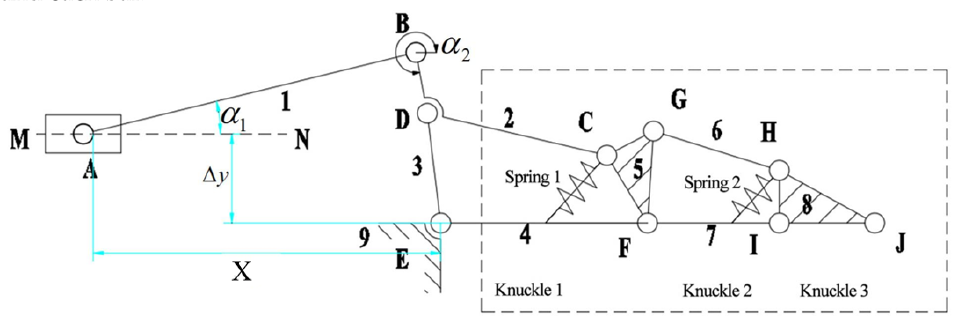
5 of 20 Figure 3. Finger mechanism of the underactuated manipulator.